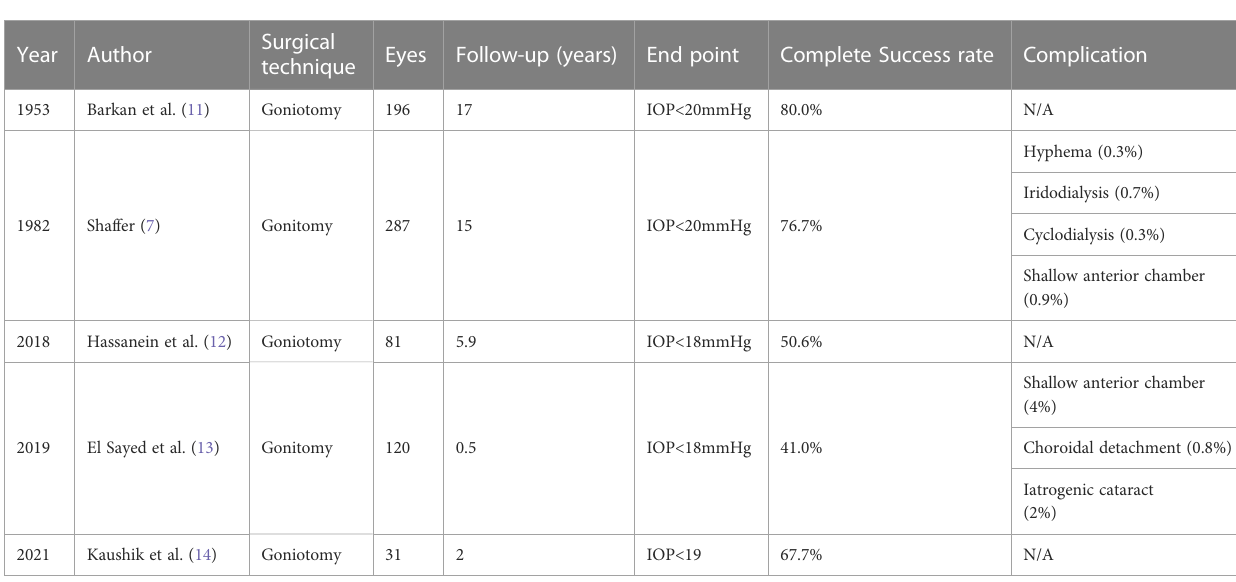
TABLE 1 Studies on goniotomy for primary congenital